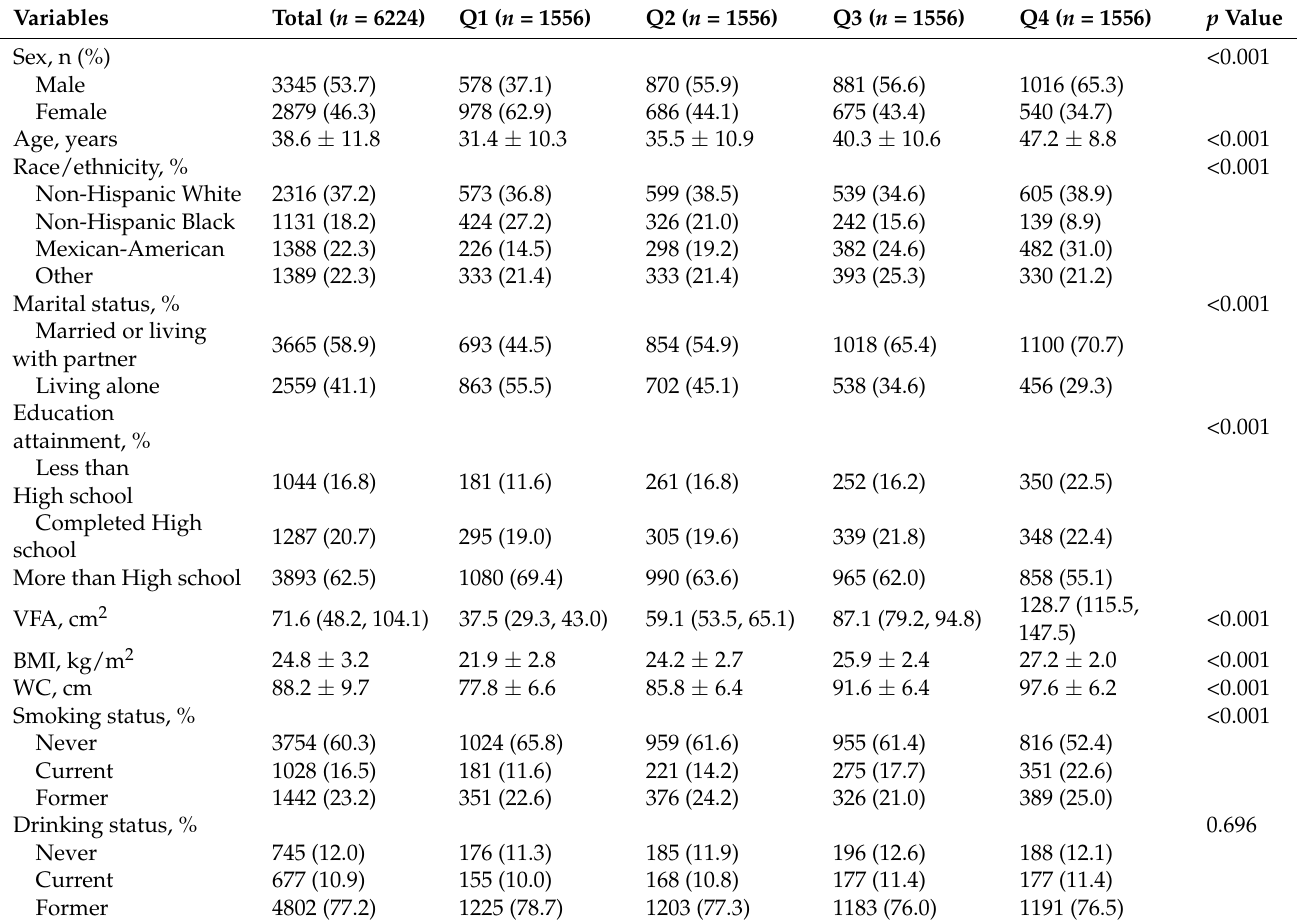
Table 1. Baseline characteristics of the study participants according to